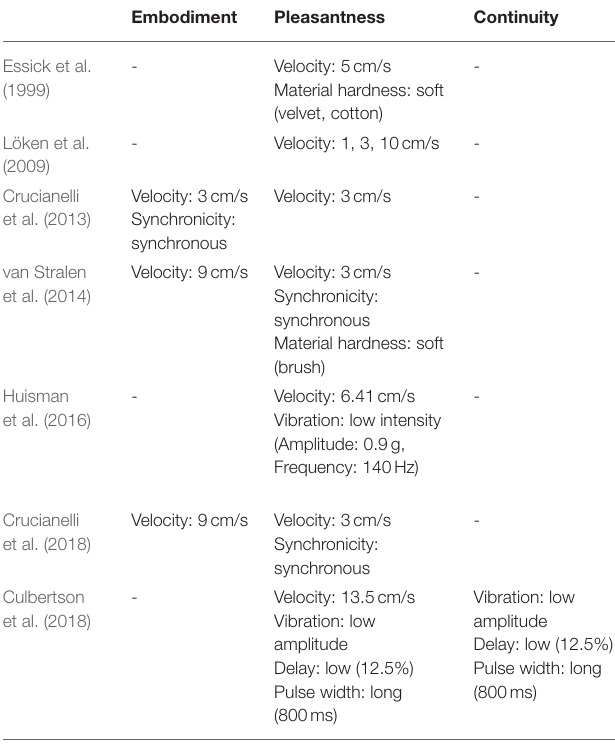
TABLE 1 | Optimal parameters of stimulation to maximize psychological factors mentioned in section